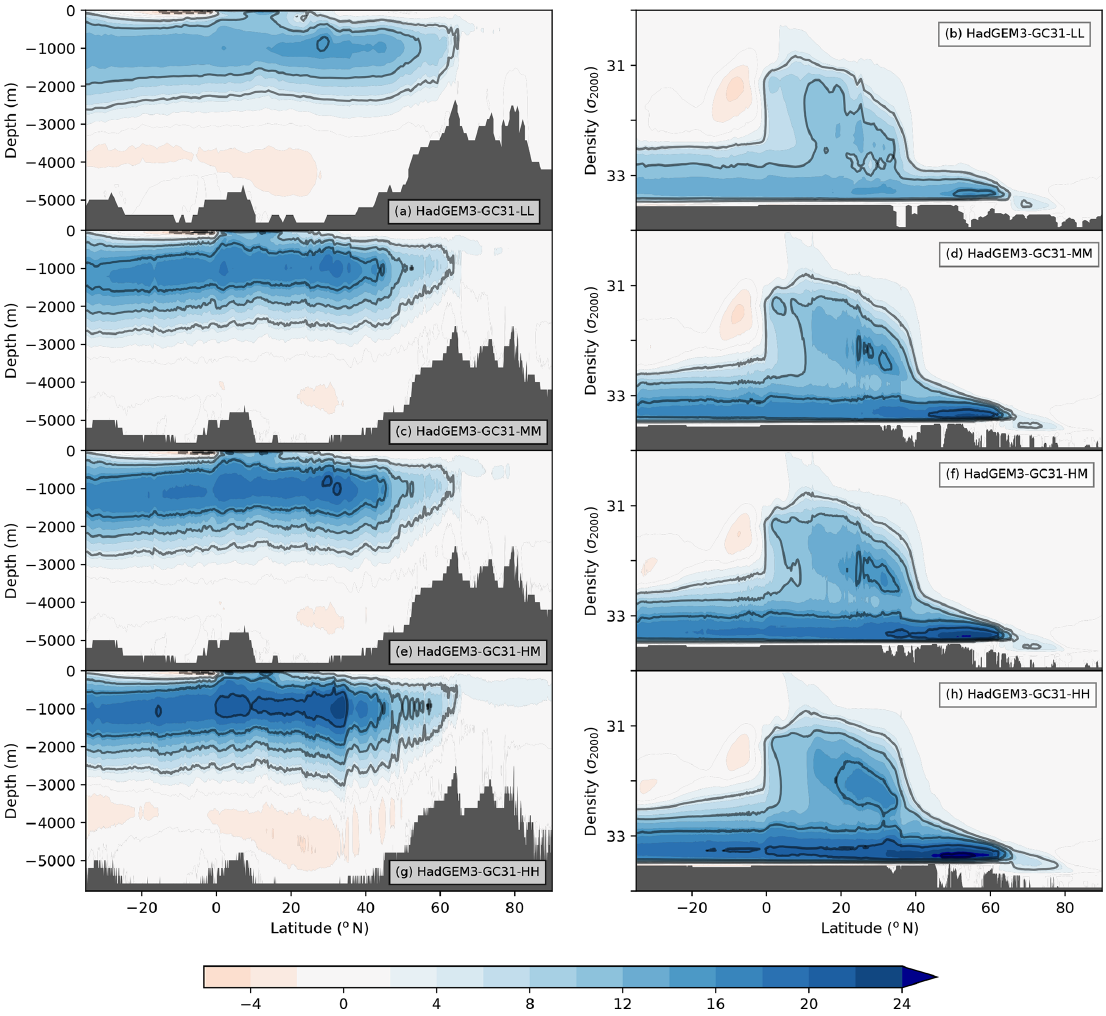
Figure 16. Atlantic meridional overturning streamfunction in (left) depth coordinates and (right) potential density ( σ 2000 ) coordinates, averaged over years 50–100, in units of Sv (10 6 m 3 s − 1 ). The contours are at 5Sv intervals (excluding